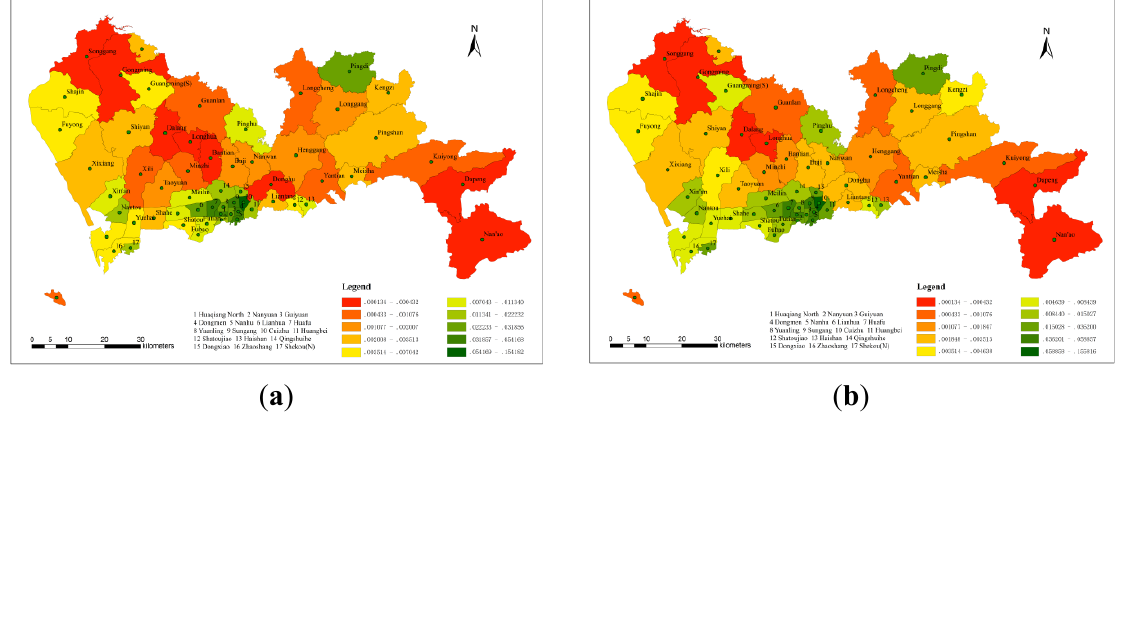
Figure 8. The spatial access in each sub-district. ( a ) 6, 3, 1.7 km (non-interpolated); ( b ) 9, 4, 2 km (non-interpolated); ( c ) 12, 5, 2.3 km (non-interpolated); ( d ) 6, 3, 1.7 km (with kriging); ( e ) 9, 4, 2 km (with kriging); ( f ) 12, 5, 2.3 km (with